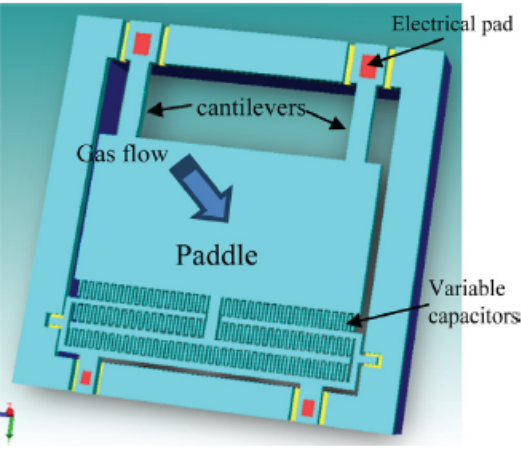
Figure 22. Schematic diagram of MEMS capacitive flow sensor, fabricated using silicon-on-insulator (SOI) wafers. The paddle is perpendicular to the direction of gas flow. Reprinted from Sensors and Actuators, Volume 231, Nguyen, S.D; Paprotny, I.; Wright, P.K.; White, R.M. MEMS Capacitive